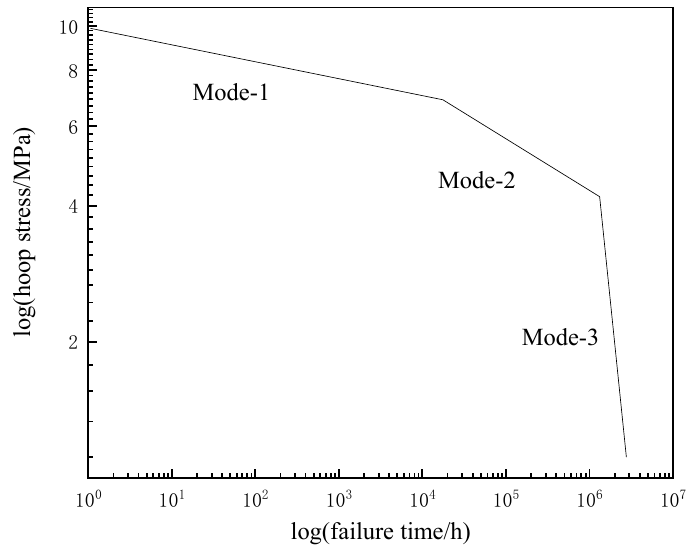
Figure 1. Schematic diagram of failure behaviors of PE pipes [7].